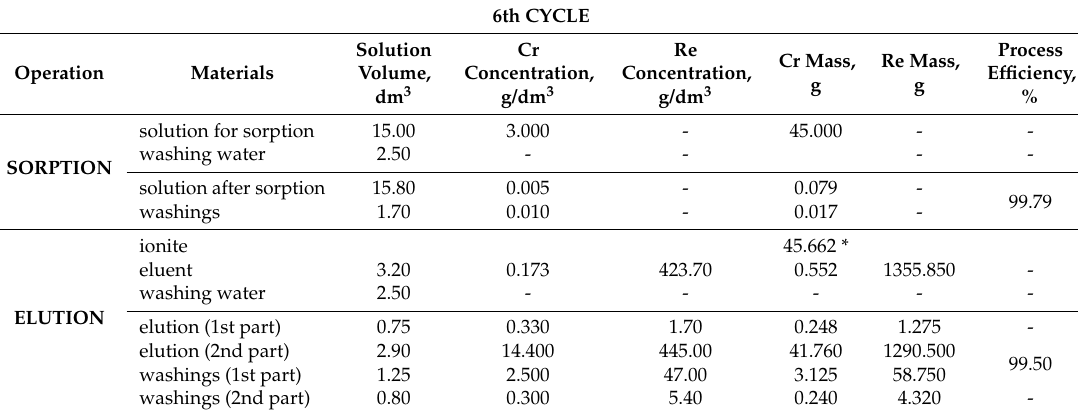
Table 6. Chromium(III) sorption and elution balance—6th cycle. 6th